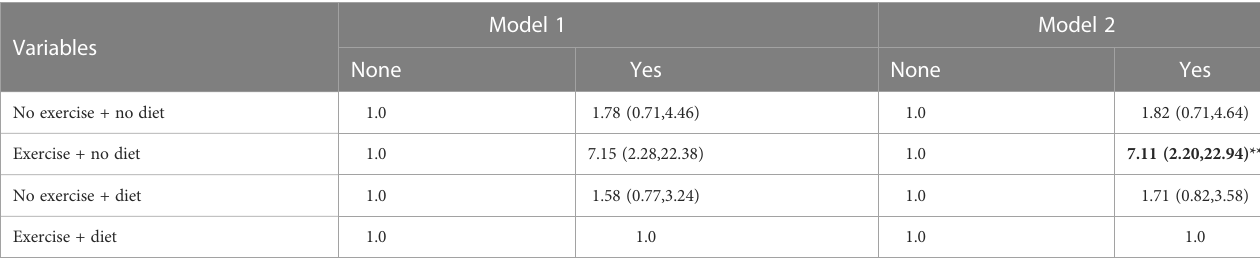
TABLE 14 The correlation between intervene and CVD (female).